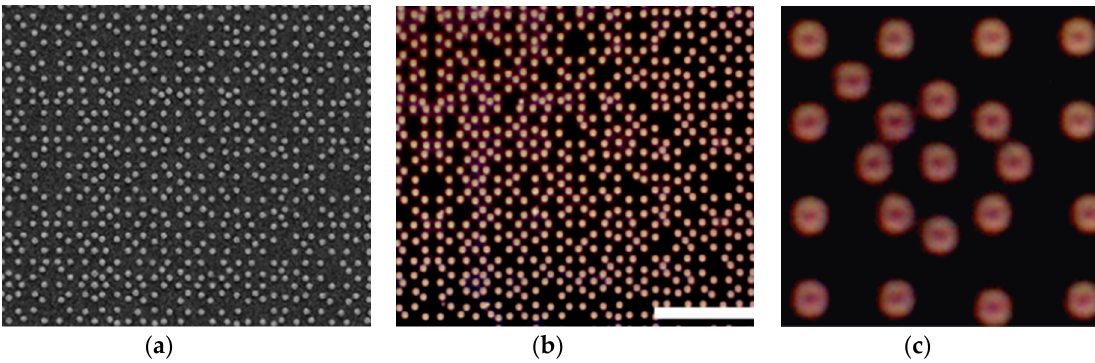
Figure 4. Comparative analysis of ( a ) octagonal symmetry of plasmonic quasi-crystal on glass (SEM image; columns diameter: approximately 750 nm) and ( b ) the complementary transferred on the surface of the PMP film (DFM; Magnification: 50×). ( c ) Zoom of the structure shown in ( b ).